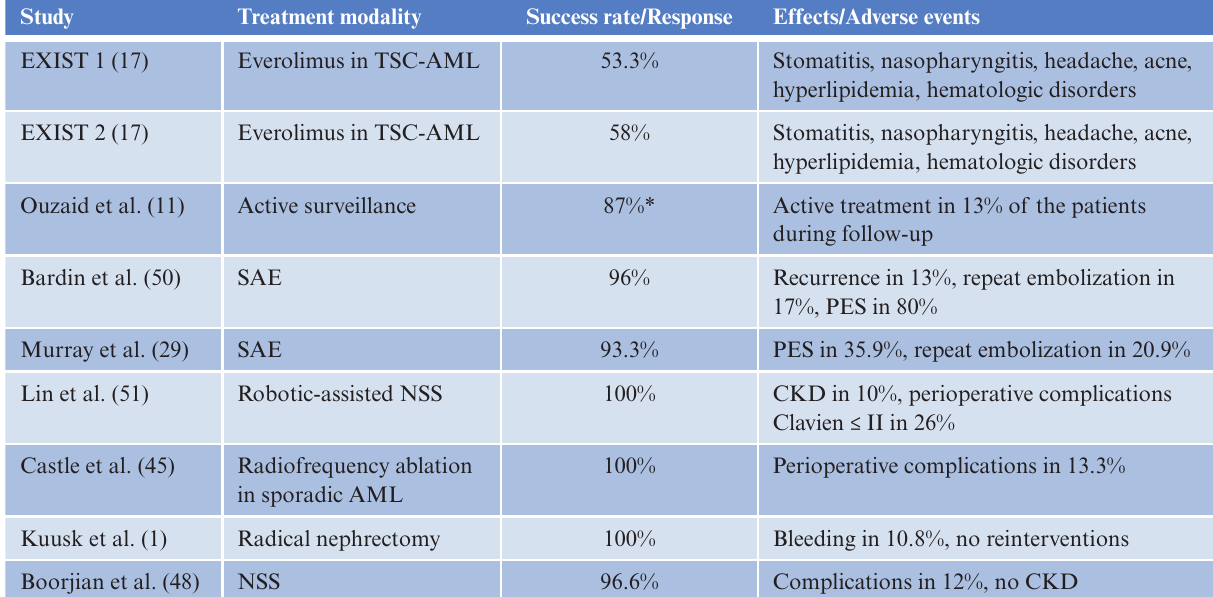
Table 1: Case series in renal AML management.